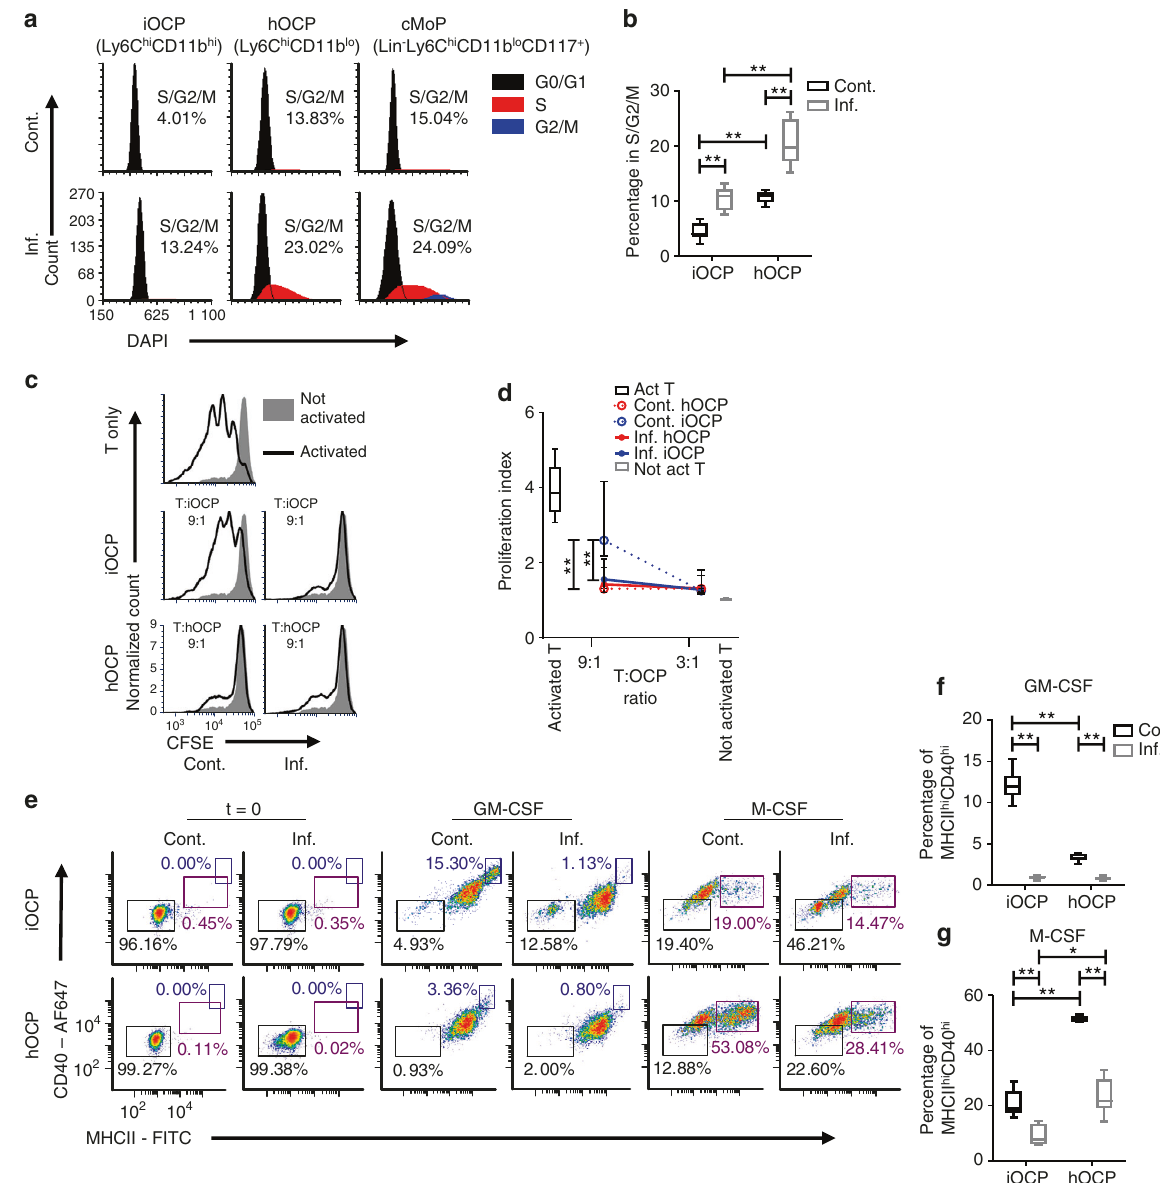
Fig. 5 iOCPs and hOCPs are functionally distinct myeloid precursor populations. a Cell cycle staining of iOCPs (Ly6C hi CD11b hi ) and hOCPs (Ly6C hi CD11b lo ) in the BM of control and in fl amed mice. Lin - Ly6C hi CD11b lo CD117 + cMoPs were used as a positive control, and iOCPs and hOCPs were identi fi ed from the CD117 - gate. b The frequency of cells in the S/G2/M phase. n = 6 for each group, representative of two independent experiments. c Representative plots for the T-cell proliferation suppression assay at a 9:1 T cell:OCP ratio with iOCPs and hOCPs. d The proliferation indices at 3:1 and 9:1 T cell:OCP ratios are presented. n = 5 for each group, representative results for 2 independent experiments. e MHCII and CD40 expression of iOCPs and hOCPs sorted from the BM of control or in fl amed mice after 3 days in culture with GM-CSF or M-CSF. f The fraction of MHCII hi CD40 hi differentiated cells in GM-CSF-containing cultures. g The frequency of MHCII hi CD40 hi differentiated cells in M-CSF-containing cultures. n = 6 for each group, representative results for 3 independent experiments. Line/circle: median, box: 25th-75th percentile, whiskers: range. * P < 0.05, ** P < 0.01 (Mann – Whitney test and Holm multiplicity correction) in fl ammation. We then searched the data for proton pumps, comparative proteomic pro fi ling to elucidate the differences adhesion molecules and proteases, which are protein classes that between in fl amed iOCP-OCs and hOCP-OCs (4 biological replicates have been previously associated with OC activity. The subunits and each). A total of 5 530 proteins were detected, of which 692 were associated proteins of the V-type proton pump complex were all preferentially expressed by iOCP-OCs and 1 083 by hOCP-OCs more highly expressed in iOCP-OCs, with the OC-speci fi c TCIRG (Limma, Benjamini – Hochberg false discovery rate (FDR) = 0.05) and ATP6v0d2 subunits most prominently expressed (Fig. 6f, left (Fig. 6d). Signi fi cant iOCP-OC-speci fi c proteins were enriched in GO panel). Most adhesion molecules were preferentially expressed by categories including mitochondrial, lipid and acid metabolic iOCP-OCs, with components of the OC-speci fi c α V β 3 integrin processes (Fig. 6e), while hOCP-OC-speci fi c proteins were enriched complex (ITGAV and ITGB3) exhibiting the highest expression in only DNA replication (GO:0006260). This shows that iOCP-OCs (Fig. 6f, middle panel). Protease expression was also higher in iOCP- are more metabolically active than hOCP-OCs during chronic Bone Research (2022)